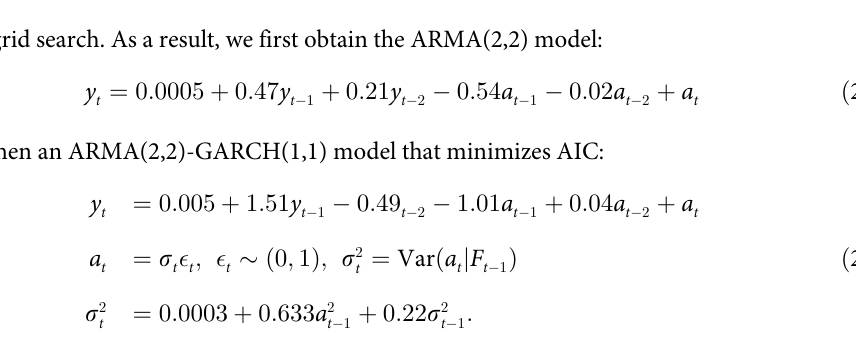
We then apply a grid search to the validation set to determine the free parameters of SVR. Parameters γ , γ , and � are selected from {0.01, 0.02, . . . , 0.1}, and parameter � is selected h g g h from {0.1, 0.2, . . . , 1}. Also, parameters C and C are selected from {0.5, 0.6, . . . , 1.5}. h g For comparison, we also consider three neural network methods: RNN, LSTM, and GRU, with two hidden layers. Here, the number of hidden layer neurons in the network is selected by a grid search from {2, 4, 8, . . . , 256}. We also build a neural network model for the ^ a 2 t sequence to predict the conditional variance. For measuring the accuracy of prediction, we use metrics: NMES, Sign error, and RMSE_var, wherein the number of repetition is 100. Table 2 shows that the neural network model has better predictive ability than the traditional time series models (ARMA and ARMA-GARCH), but underperforms the SVR-ARMA-GARCH model, and further, the ARE method performs better in the SVR-ARMA-GARCH model. Change point detection. To perform a residual-based CUSUM test, we use the residuals obtained based on the ARE method and apply T UCL , T , and T scale to the BDI data to detect a max s max change point from 2019/01/01 to 2021/04/06. In this task, we use the rolling window scheme with the width of one year and one day movement. See Fig 12. When a change point is detected, the point exceeding the control limit the most is declared as a change point. Table 2. Forecast performance of six models for the BDI data. Traditional